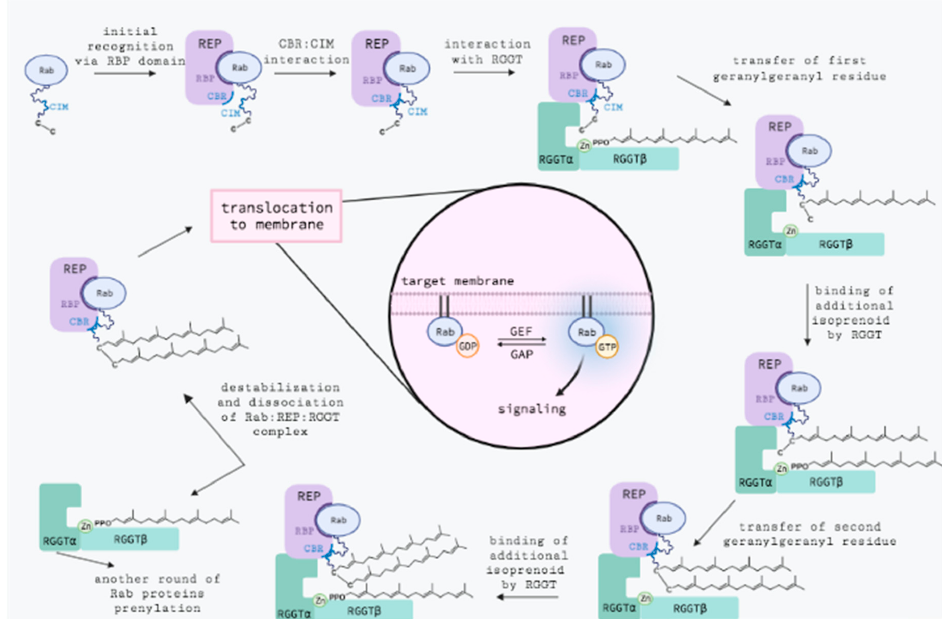
Figure 7. Model of RGGT-catalyzed protein prenylation mechanism (created in BioRender.com).